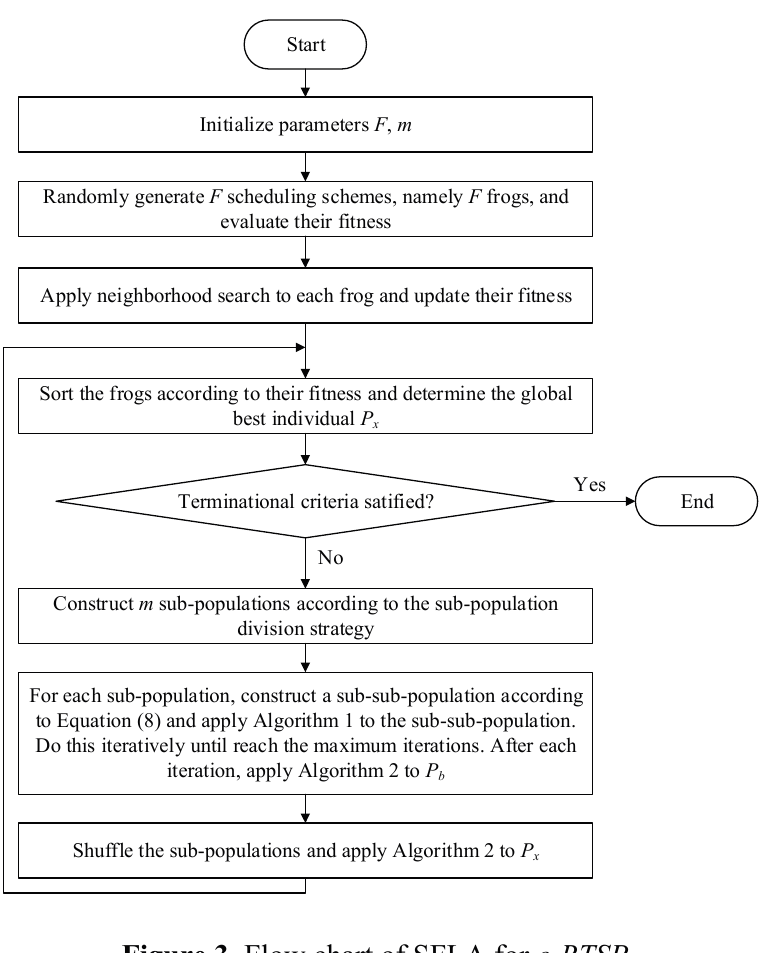
Figure 3. Flow chart of SFLA for e -